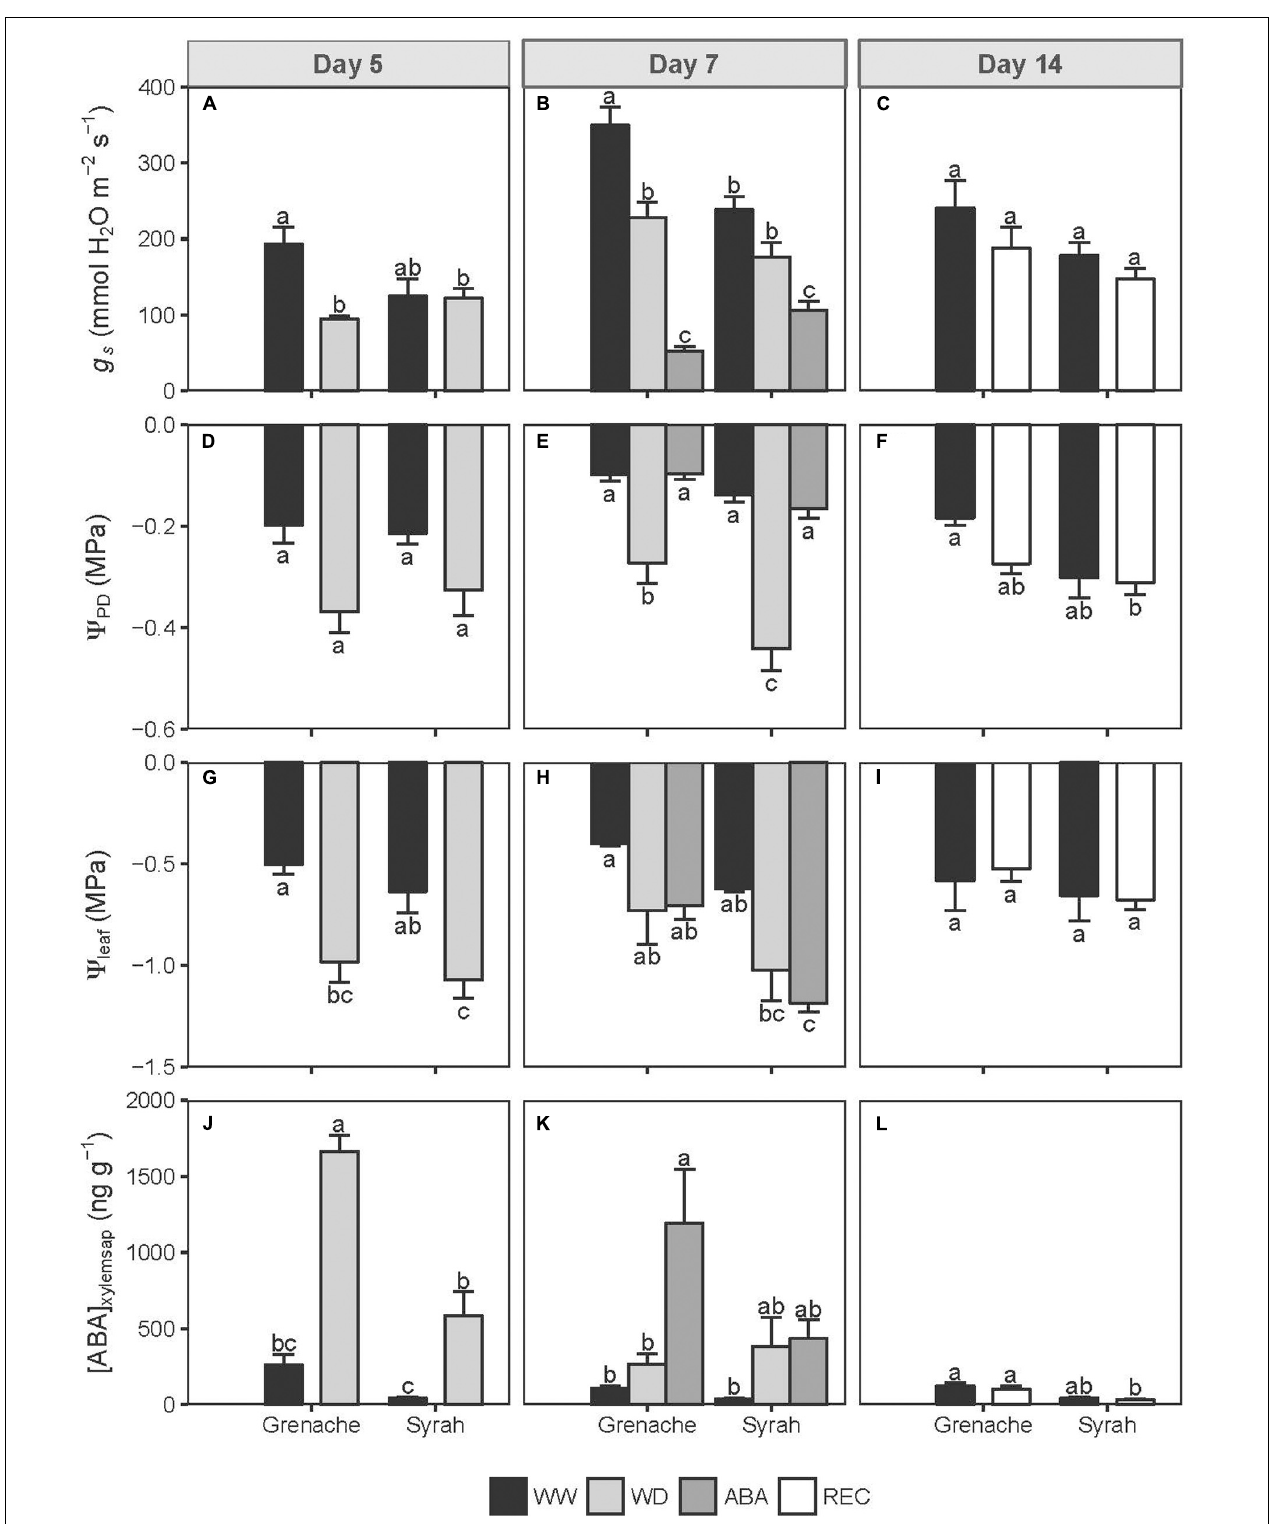
FIGURE 1 | Stomatal conductance ( g s ; A–C ), pre-dawn ( (cid:57) PD ; D–F ) and leaf ( (cid:57) leaf ; G–I ) water potentials and ABA concentration in the xylem sap ([ABA] xylemsap ; J–L ) in Grenache and Syrah grapevines under mild water deficit (WD), exogenous application of abscisic acid (ABA) and recovery from water stress (REC) at different sampling days along the experiment. Values are means ± SE ( n = 5). Different letters indicate statistically significant differences ( P ≤ 0.05) across all treatments and cultivars within the day.